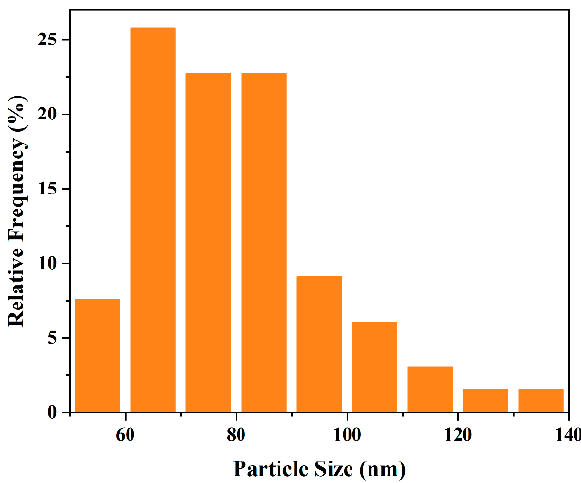
Figure 5. Particle size distribution of DST.